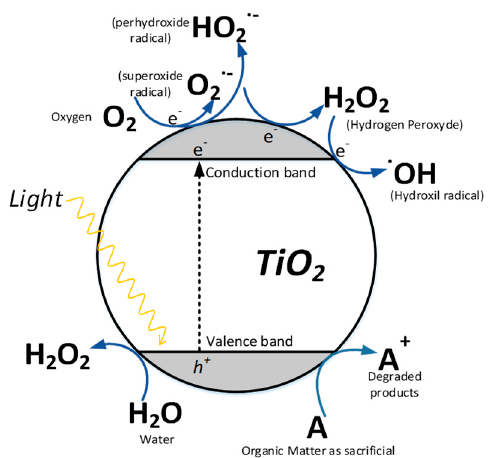
Figure 2. One electron reduction steps of oxygen to hydroxyl radical and two electron oxidation steps of water to H 2 O 2 . Adapted from Reference [32].